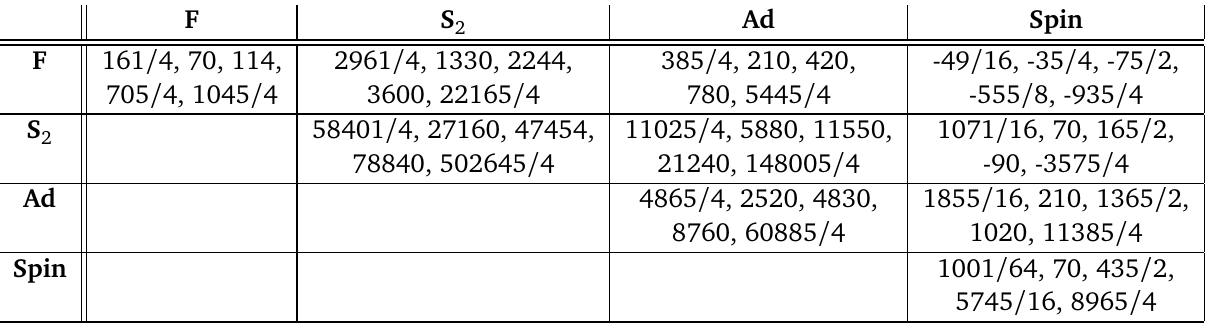
Table 9: The numerical values of d abcd ( R tively, with the choice l tiply each value by 1 / 16.